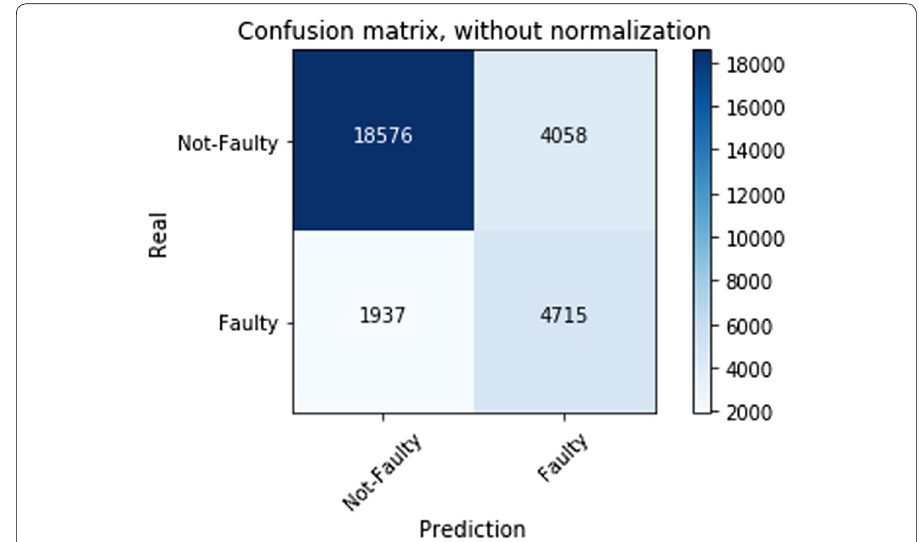
Fig. 9 Confusion matrix